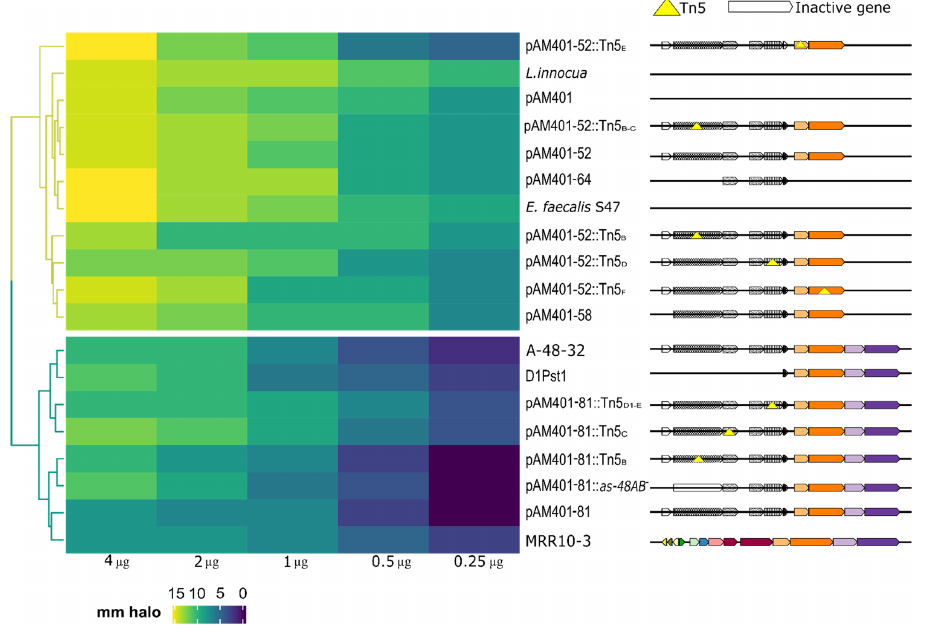
Figure 4. Sensitivity of AS-48 mutants to MR10A/B. Heatmap depicting the cluster analysis of mutant sensitivity against MR10A/B. Two main clusters emerge: sensitive strains (yellow branches) and resistant strains (blue branches). The sensi- tive cluster includes all strains without a complete functional ABC Transporter-2, whereas the resistant cluster includes all strains with a complete functional ABC transporter-2. The dendrogram shows the sensitivity of the mutant strains (rows) to different concentrations of MR10A/B (columns). The color scale represents the millimeters of halo around the colony, from dark blue (absence of halo) to yellow (largest halo (15 mm)). The righthand side shows the gene cluster for each mutant: as-48A , dotted arrow; as-48B , squared arrow; as-48C , wavy arrow; as-48C , large, dotted arrow; as-48D , striped arrow; as-48D , black arrow; as-48E , light orange arrow; as-48F , dark orange arrow; as-48G , light violet arrow; and as-48H , dark violet arrow. We used 401-81; MRR10-3 and A48-32 (wild phenotypes) served as positive controls and L. innocua , E. faecalis S-47, and E. faecalis 401 as negative controls (non-producers of AS-48 or MR10A/B). Tn5 is represented by a yellow triangle and an inactivated gene by a white arrow.